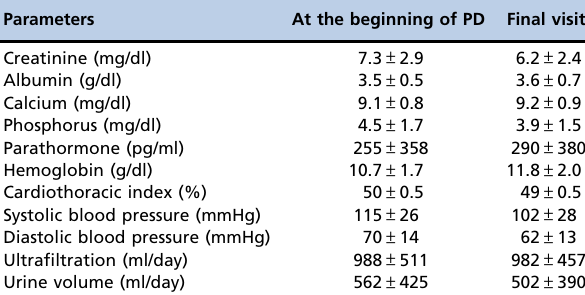
Table 2 - Clinical and laboratory data at the initiation of PD and the final visit. Parameters